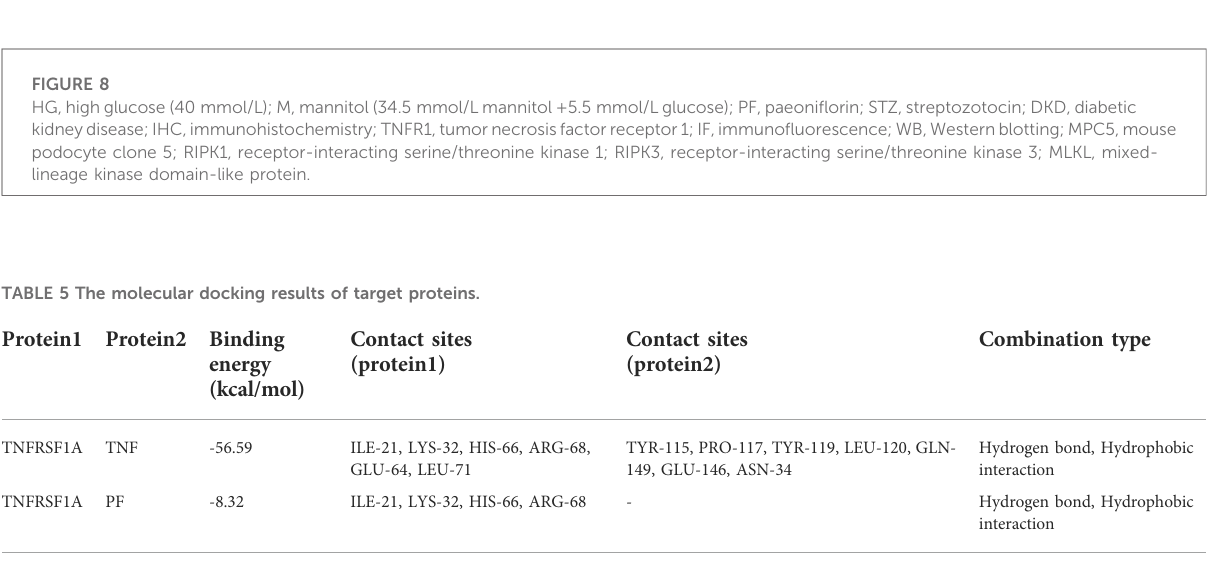
FIGURE 8 HG,high glucose (40 mmol/L); M, mannitol (34.5 mmol/L mannitol+5.5 mmol/L glucose); PF,paeoni fl orin; STZ, streptozotocin;DKD, diabetic kidneydisease;IHC,immunohistochemistry;TNFR1,tumornecrosisfactorreceptor1;IF,immuno fl